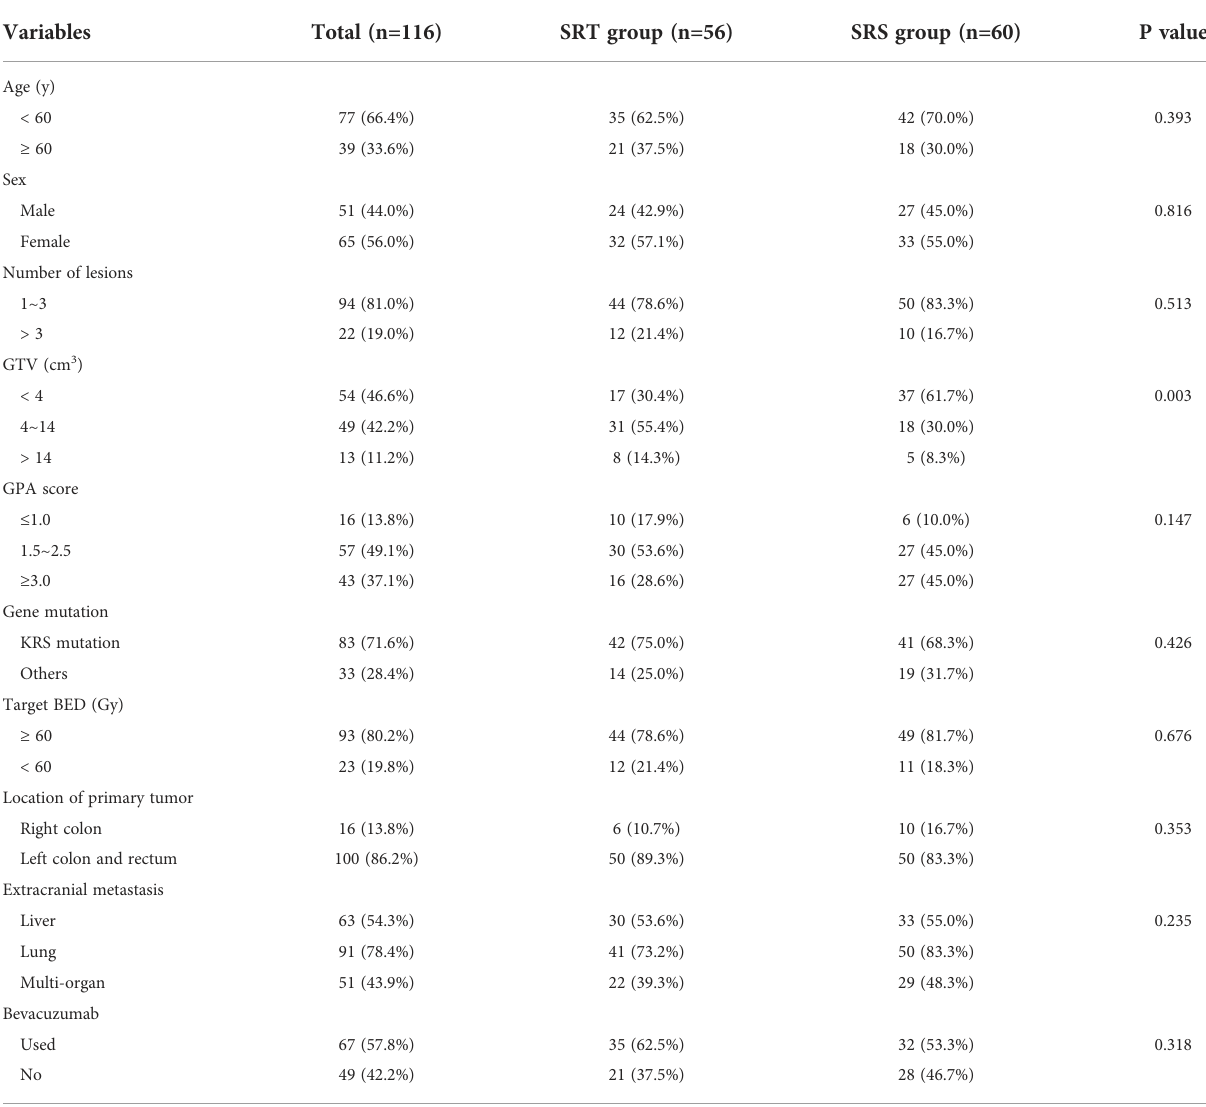
TABLE 1 Summary characteristics of patients in the SRT and SRS